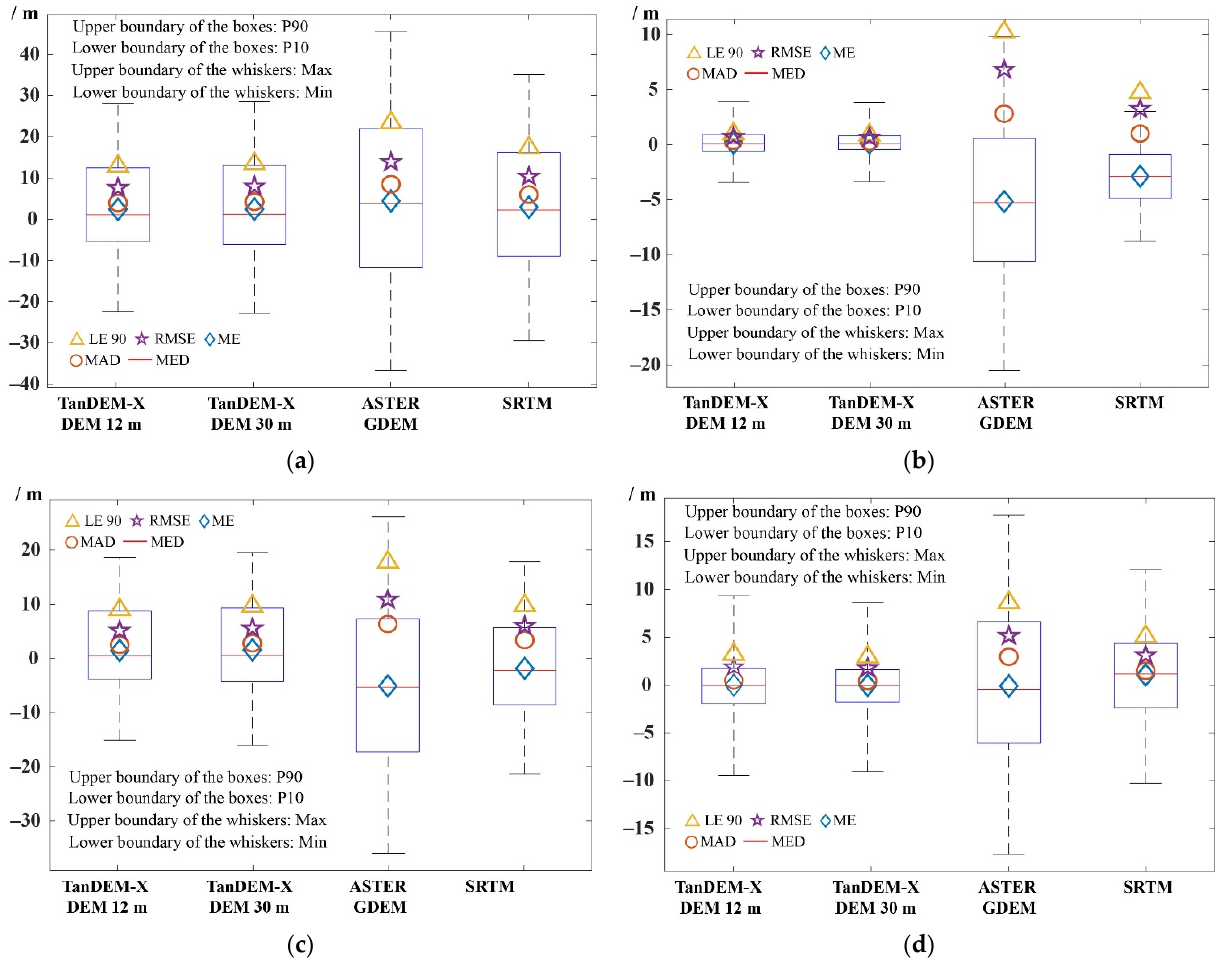
Figure 5. Quality indicators of the four assessed DEMs in study areas: ( a ) Sichuan; ( b ) Xinjiang A; ( c ) Xinjiang B; and ( d ) Inner Mongolia.